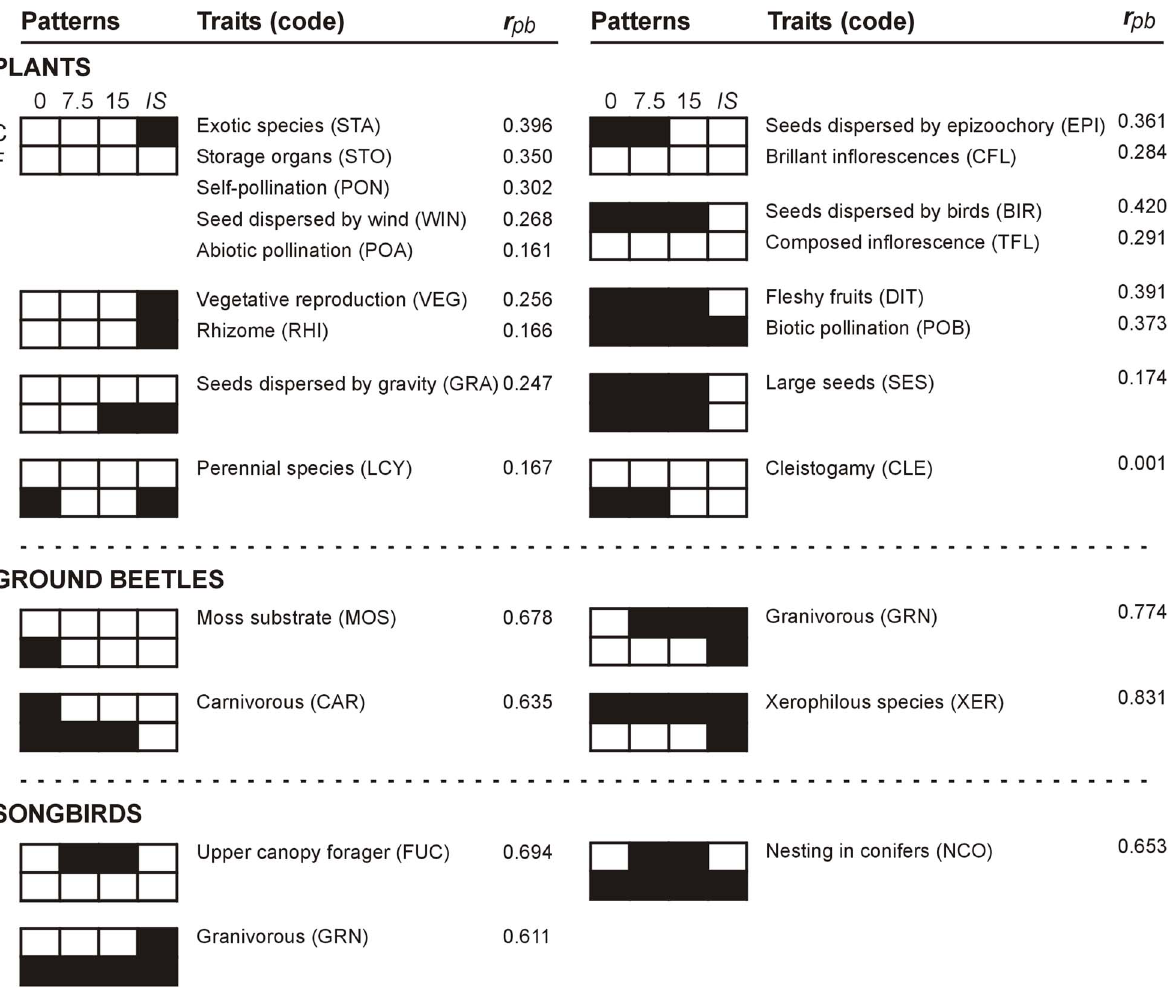
Figure 3. Traits indicators of deer density. Plant, ground beetle and songbird traits found to be indicators of at least one deer density experimental condition (0, 7.5 or 15 deer ? km 2 2 ; IS = in situ deer density, i.e., . 27 deer ? km 2 2 ). Black squares indicate significant positive correlations between the occurrence of a trait and a specific or several deer densities ( P # 0.05). Point-biserial correlation coefficient (r pb ) is indicated for each trait. Traits that only indicate a vegetation cover type (C= cut-over areas; F= uncut forests) are not